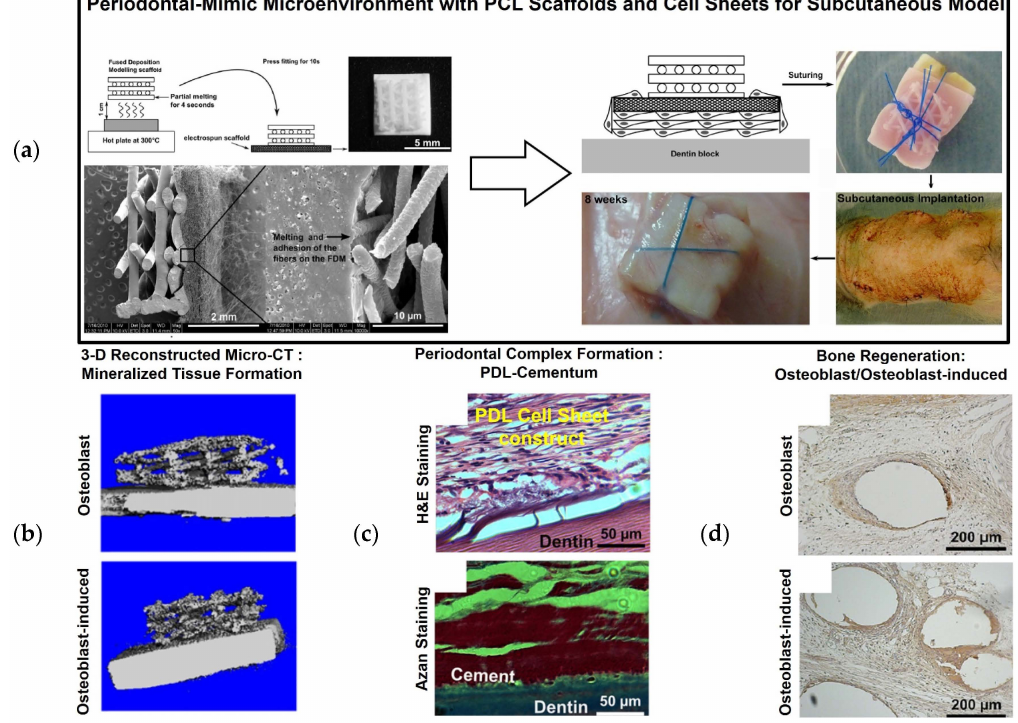
Figure 3. Periodontal regeneration construct using a poly- ε -caprolactone (PCL) nanofibrous